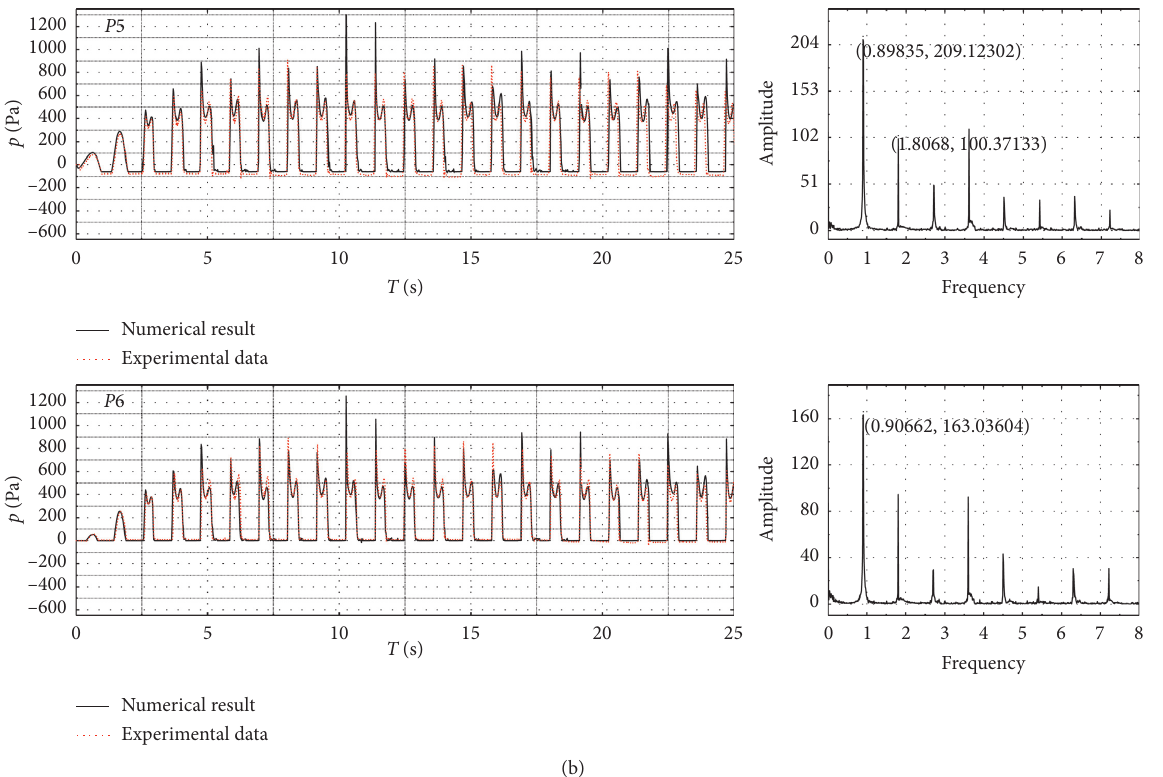
Figure 9: Comparison of the pressure between the experimental data and the numerical results and FFTspectrum of the time histories of pressure at tank wall.